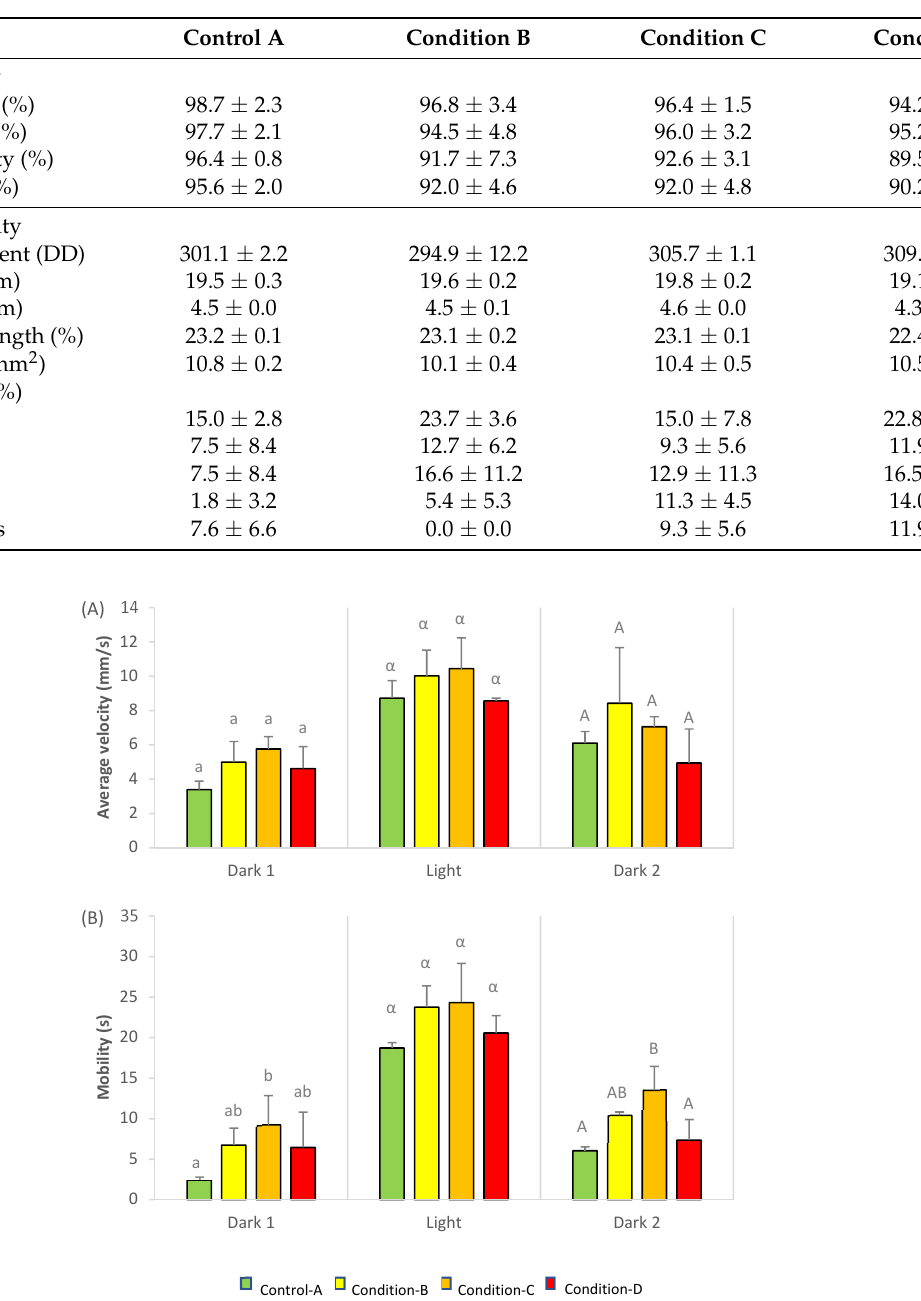
Table 3. Viability and developmental anomalies of early life stages of rainbow trout exposed to a mixture of three pesticides, copper, glyphosate and chlorpyrifos. Values represent Mean ± SD. No significant differences were observed, n = 3, ANOVA.